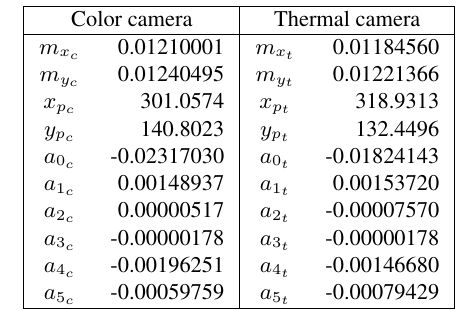
Table 2. Results of joint FLIR ONE PRO cameras calibration